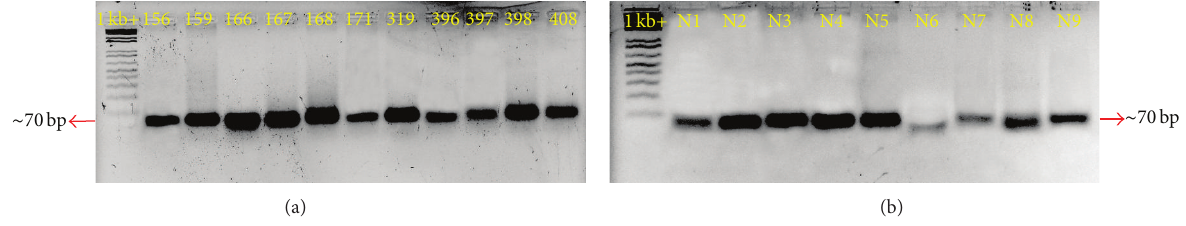
Figure 5: Agarose gel electrophoresis of known and novel miRNAs identified in jute. (a) Amplicons for known miRNAs. 156: miR156, 159: miR159, 166: miR166, 167: miR167, 168: miR168, 171: miR171, 319: miR319, 396: miR396, 397: miR397, 398: miR398, and 408: miR408. (b) Amplicons for novel miRNAs. N1: col-miRN1, N2: colmiRN2, N3: colmiRN3, N4: colmiRN4, N5: colmiRN5, N6: colmiRN6, N7: colmiRN7, N8: colmiRN8, and N9: colmiRN9.